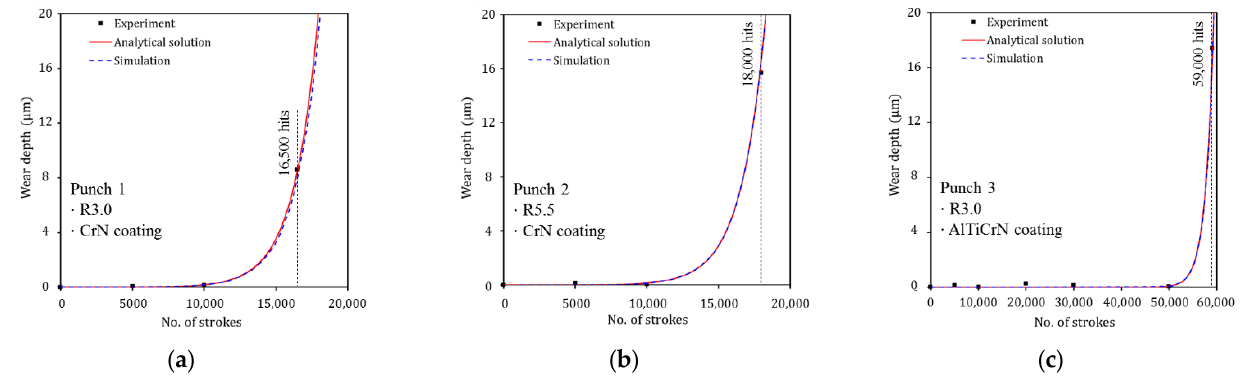
Figure 13. Comparison of the experimental results, analytical solution, and simulation results based on the revised Archard’s wear model with respect to the number of strokes: ( a ) Punch 1 with a radius of 3.0 mm coated with PVD CrN, ( b ) Punch 2 with a radius of 5.5 mm coated with PVD CrN, and ( c ) Punch 3 with a radius of 3.0 mm coated with PVD AlTiCrN.